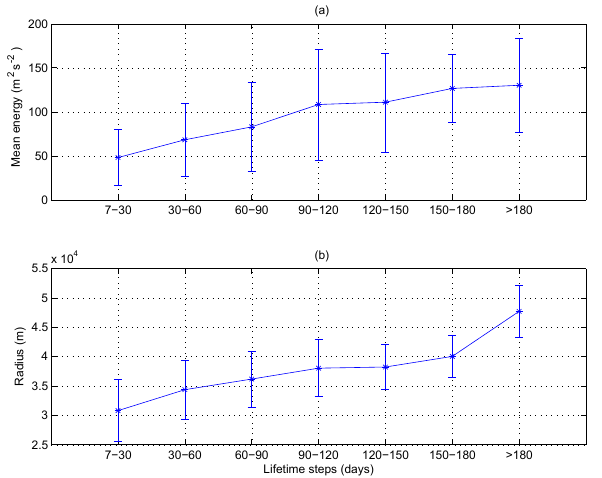
Figure 9. Relation between MEKE (a) , radius (b) and lifetime of anticyclonic structures. Averages have been computed on the basis of MEKEs and mean radii of the anticyclonic eddies in the basin.